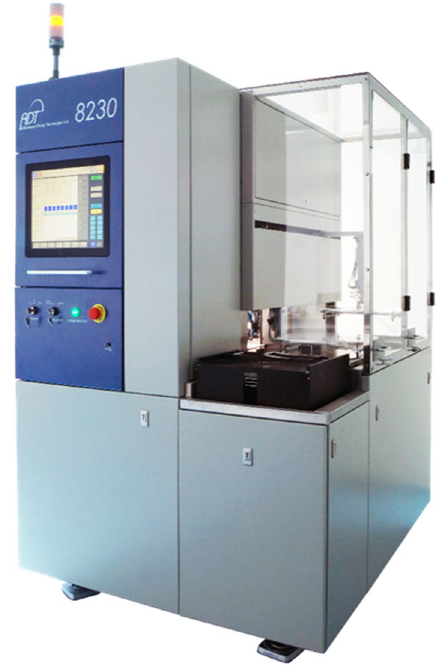
Fig. 2 Israeli ADT8230 automatic dicing saw